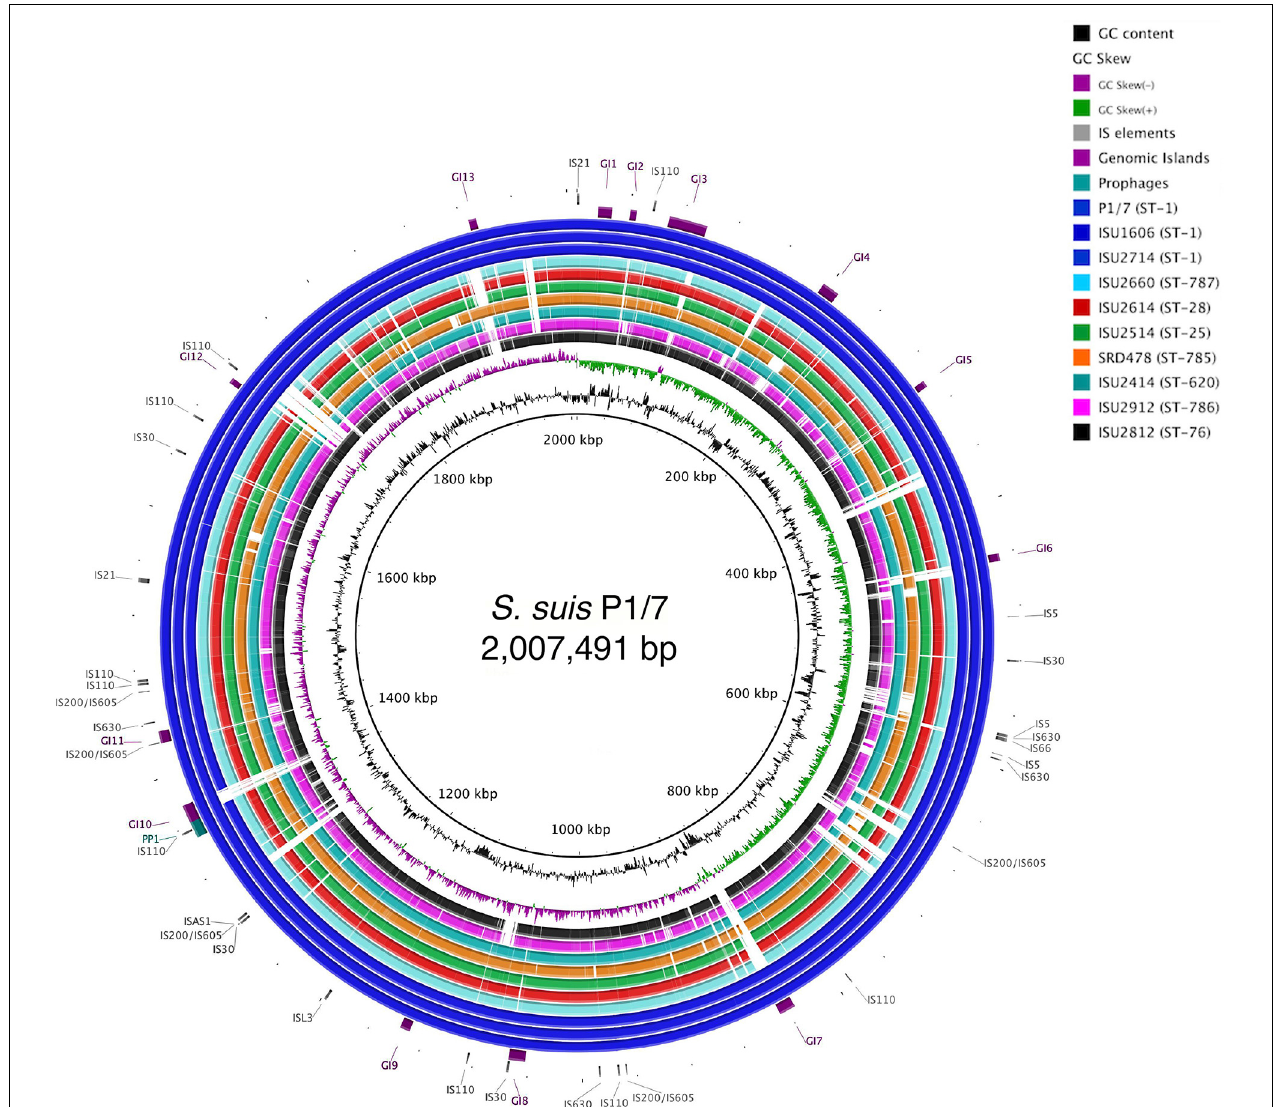
FIGURE 2 | Genome visualization of S. suis chromosomes. Circular comparison of the of nine closed S. suis chromosomes referenced to the genome of ST-1 strain P1/7. Query genomes are and plotted from outermost to innermost ring and shown top to bottom in the legend. GC-content and -skew of the reference chromosome are depicted in the two innermost circles, respectively. Identified MGEs are shown as follows Genomic Islands (GI), ProPhage regions (PP), and Insertion elements (IS).